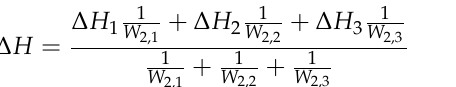
where 𝑊 1,1−3 and 𝑊 2,1−3 are the standard deviation of residuals from the regression analysis to obtain Equation (11) for the individual channel. See the left side of Figure 2a.